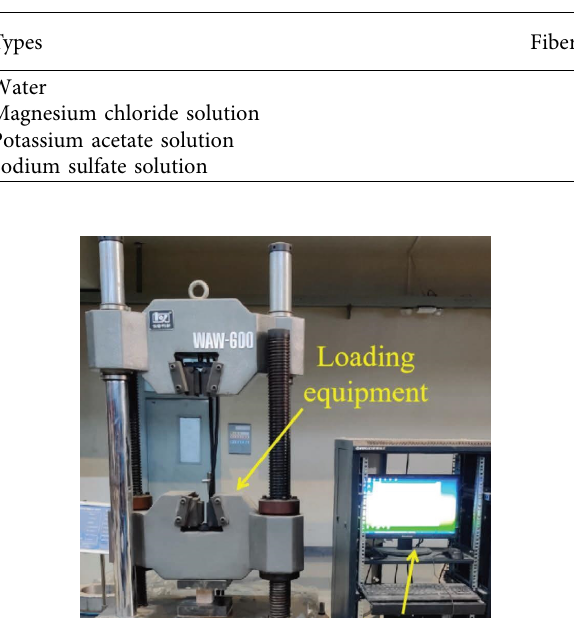
Table 4: Test plan.